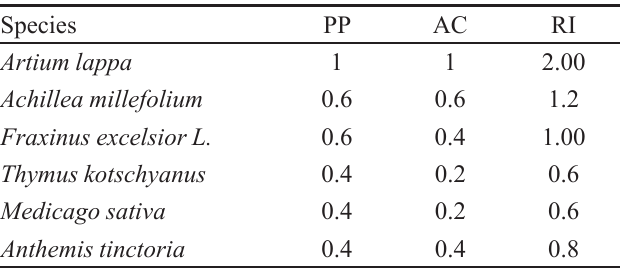
TABLE VI - Relative Importance (RI) values for Mahabad medicinal plants used against or more specific use categories and three or more ailments categories